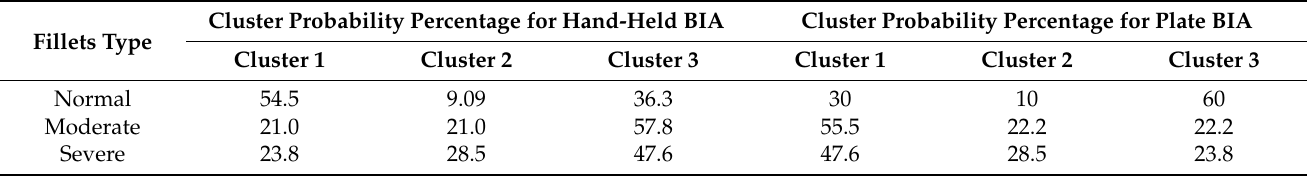
Table 2. Percentage probability of fillets grouped into three different